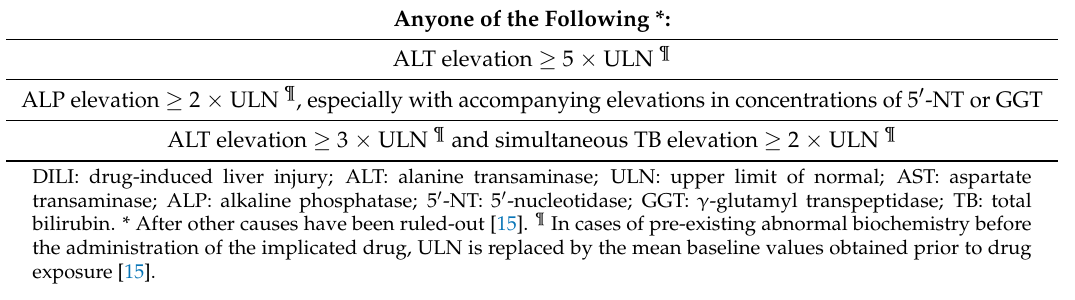
Table 1. Clinical chemistry criteria for